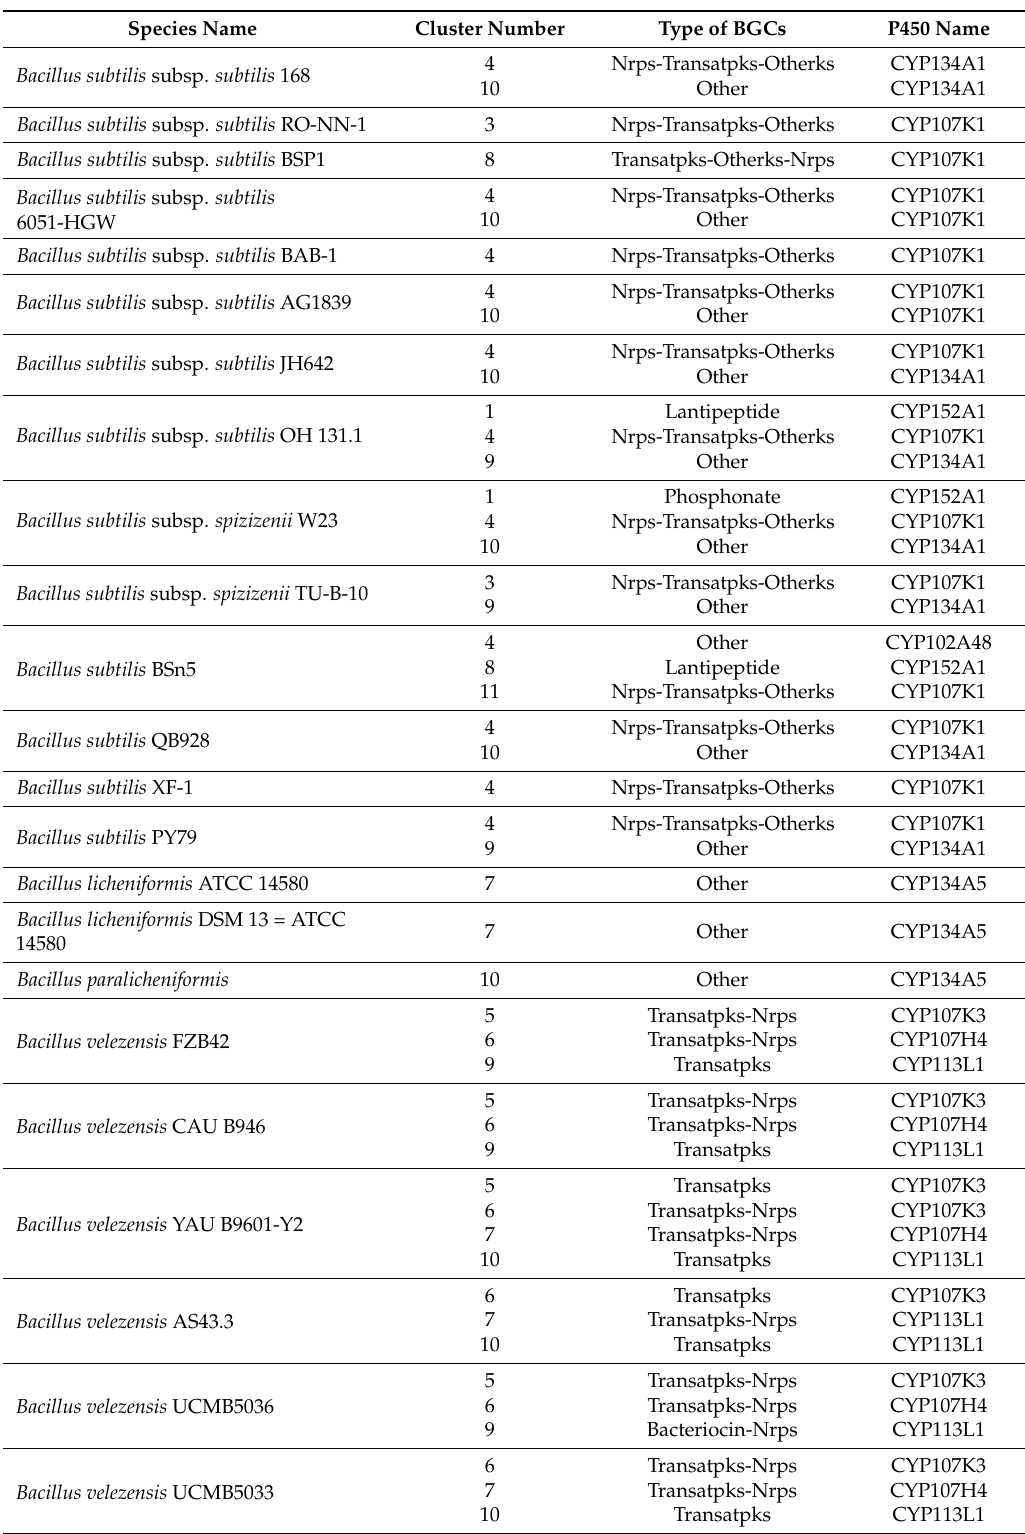
Table 1. Identification of P450s that are involved in secondary metabolite BGCs in Bacillus species. BGCs in each species and P450 identified as part of a particular cluster are presented in Supplementary Dataset